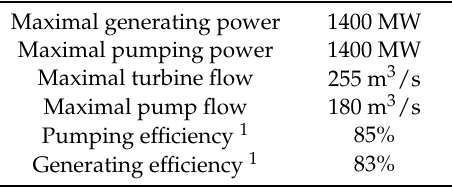
Table 1. Basic characteristics of the Tonstad